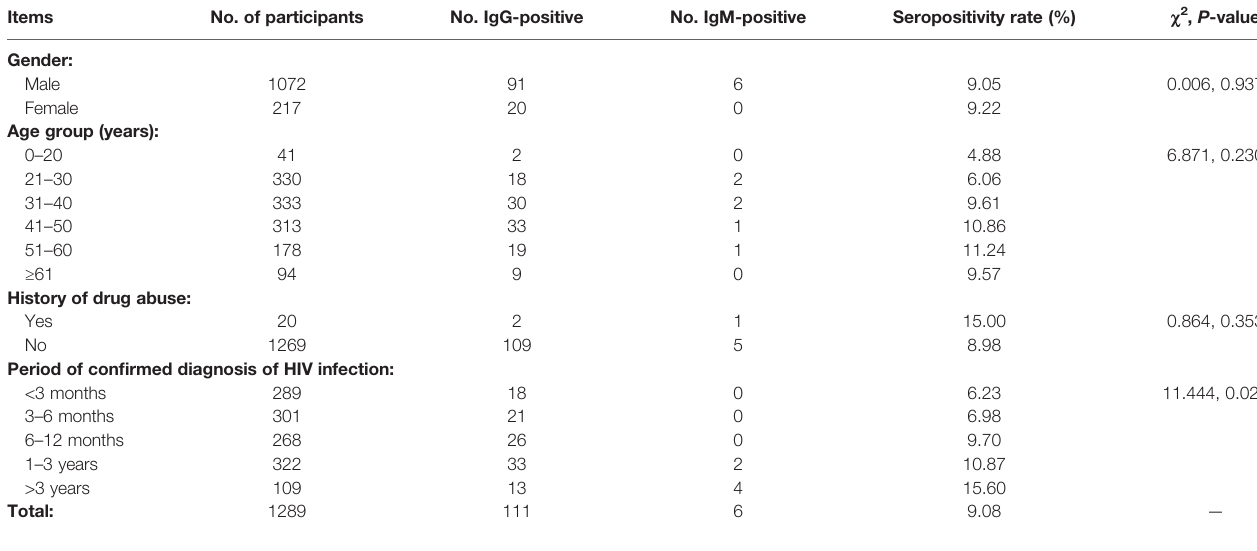
TABLE 1 | Seroprevalence of toxoplasmosis in HIV/AIDS patients. No. IgG-positive No. IgM-positive Seropositivity rate (%)